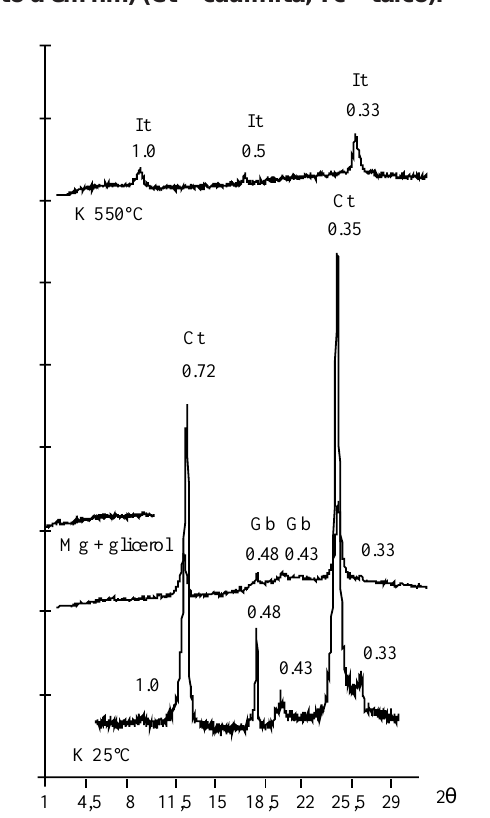
Figura 5. Difratogramas de raios-X da amostra 1BC (Perfil 1 – PVAd) com os diversos tratamentos. Espaçamento d em nm (It = illita, Ct = caulinita, Gb = gibbsita).